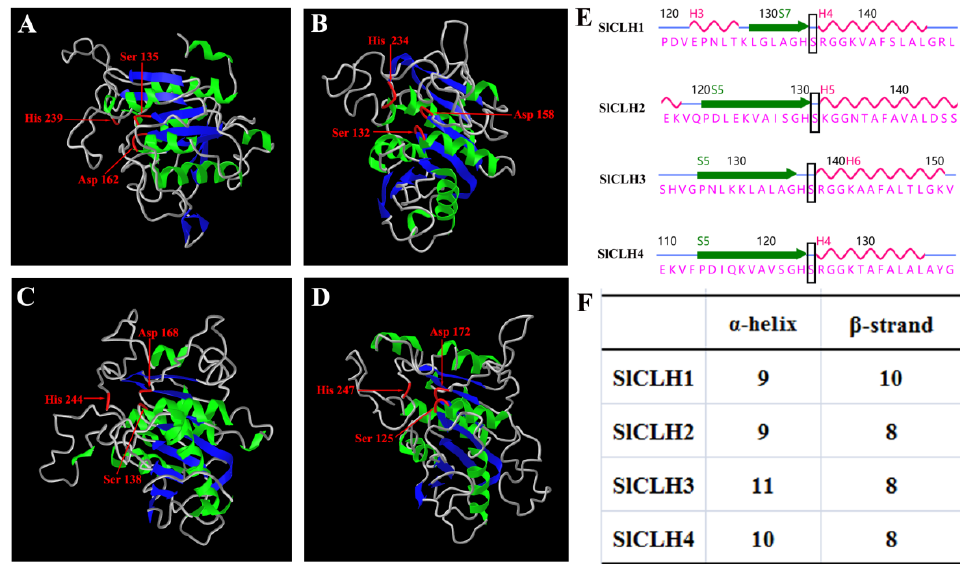
Figure 3. Predicted tertiary structure of four SlCLHs. This diagram was constructed with the SWISS-MODEL server. The conserved catalytic triad residues of SlCLH1 ( A ), SlCLH2 ( B ), SlCLH3 ( C ), and SlCLH4 ( D ) are indicated. ( E ) The number of stands and helices in the tertiary structure. The location of active serine residue in SlCLHs, which is usually at the extremely sharp turn between a β -strand and an α -helix, called the ‘nucleo-philic elbow’, a conserved structure in the α / β hydrolases. ( F ) The number of β -strands and α -helices in SlCLHs.